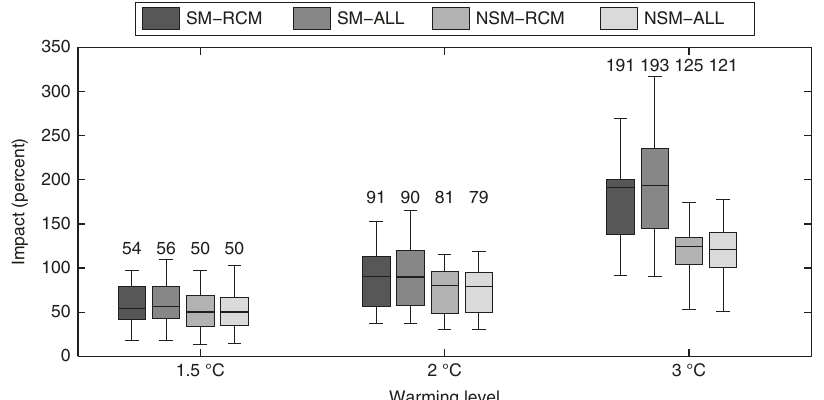
Fig. 7 Burned area changes in Mediterranean Europe using climate data without bias correction. Same as Fig. 3 but with raw climate data, i.e., without bias